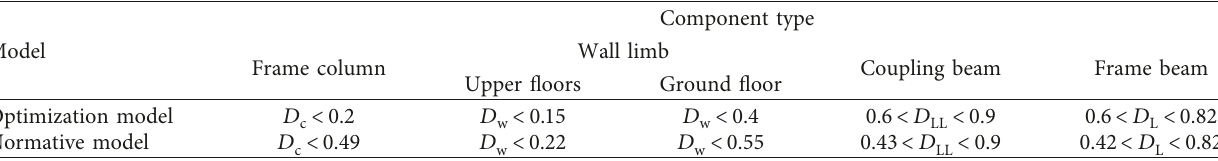
Table 4: Value of ρ